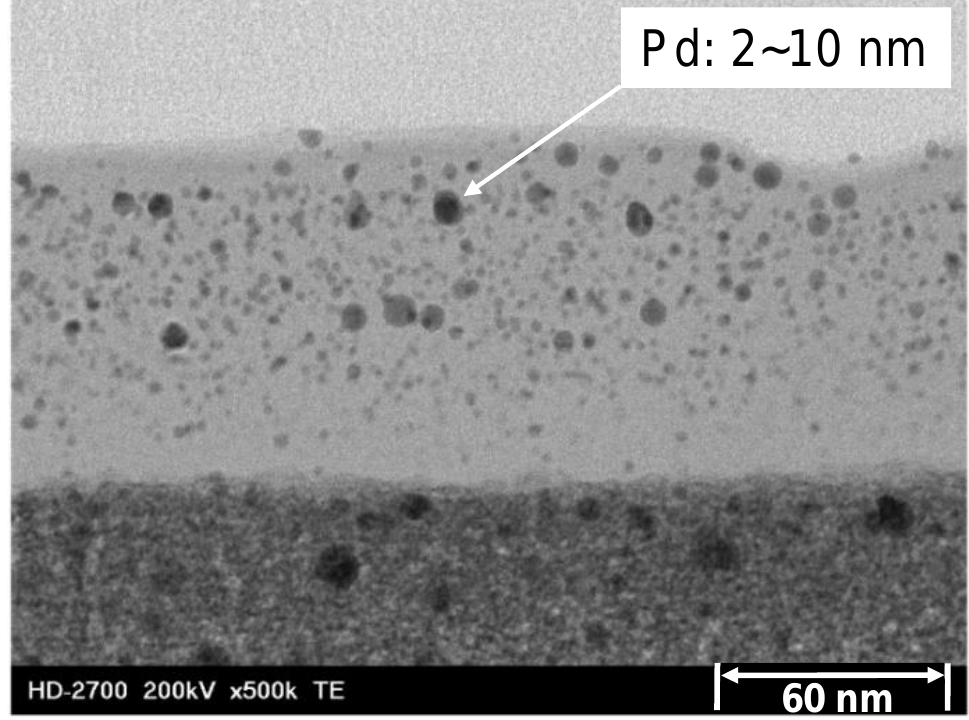
Figure 3. TEM image of the cross-section of a Pd–silica mixed-matrix membrane. Reproduced from [47].